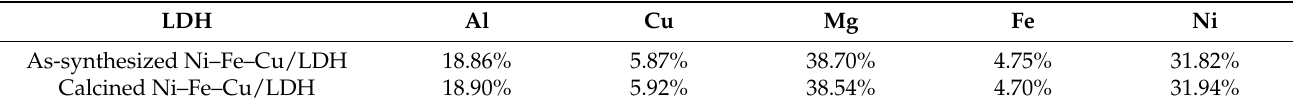
Table 3. Chemical element analysis of as-synthesized and calcined Ni–Fe–Cu/LDH.